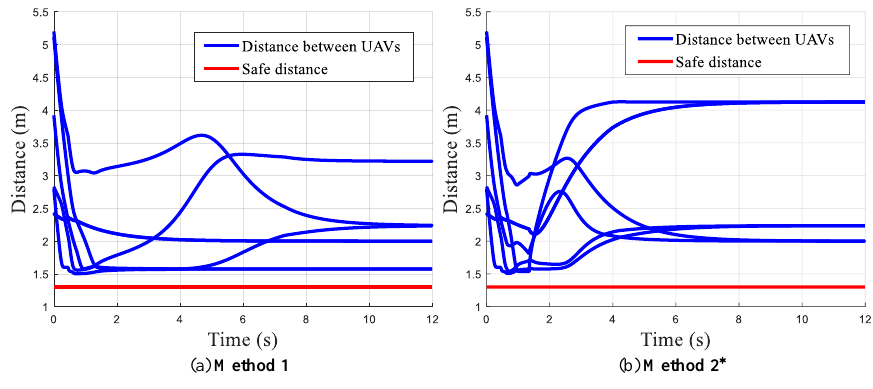
Figure 14. Distance between the UAVs.